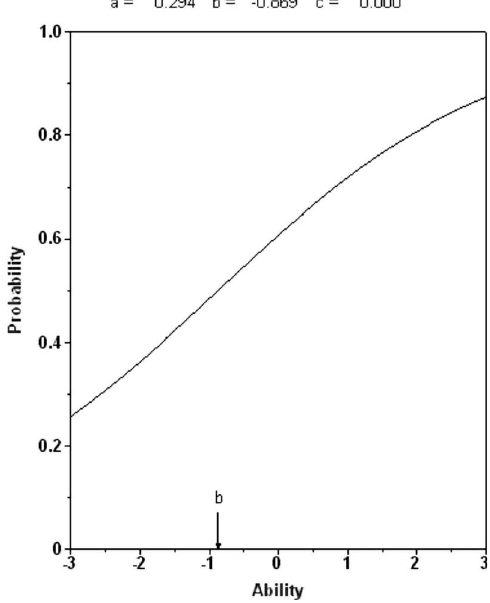
FIG. 2. Item response curve for item 41 of the 2004 11th grade